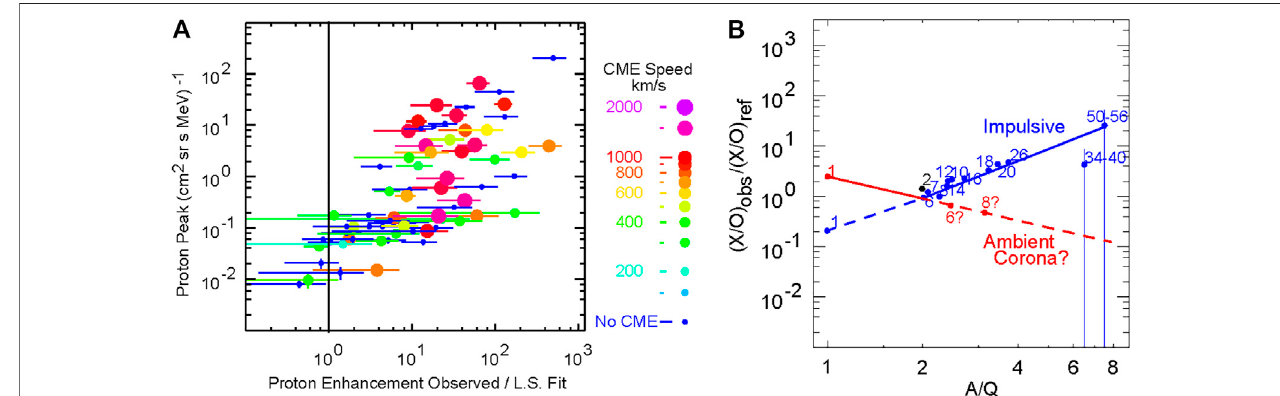
FIGURE3| Panel (A) showsthepeakprotonintensityat2 – 2.5 MeVvstheprotonexcessrelativetothe Z > 2power-law fi tforimpulsiveSEPeventswiththesymbol size and color determined by CME speed as shown. Events with fast CMEs have proton excesses. Panel (B) suggests two possible contributions to the plot of enhancement vs A/Q for the shock-enhanced SEP2 impulsive events: reaccelerated impulsive SEP1 seed particles ( blue ) and accelerated ambient coronal seed particles ( red ). Note that a shock wave can accelerate outside the volume that contains the SEP1 seed particles. If the shock is very strong, the ambient corona could dominate and the event could become a shock-dominated gradual